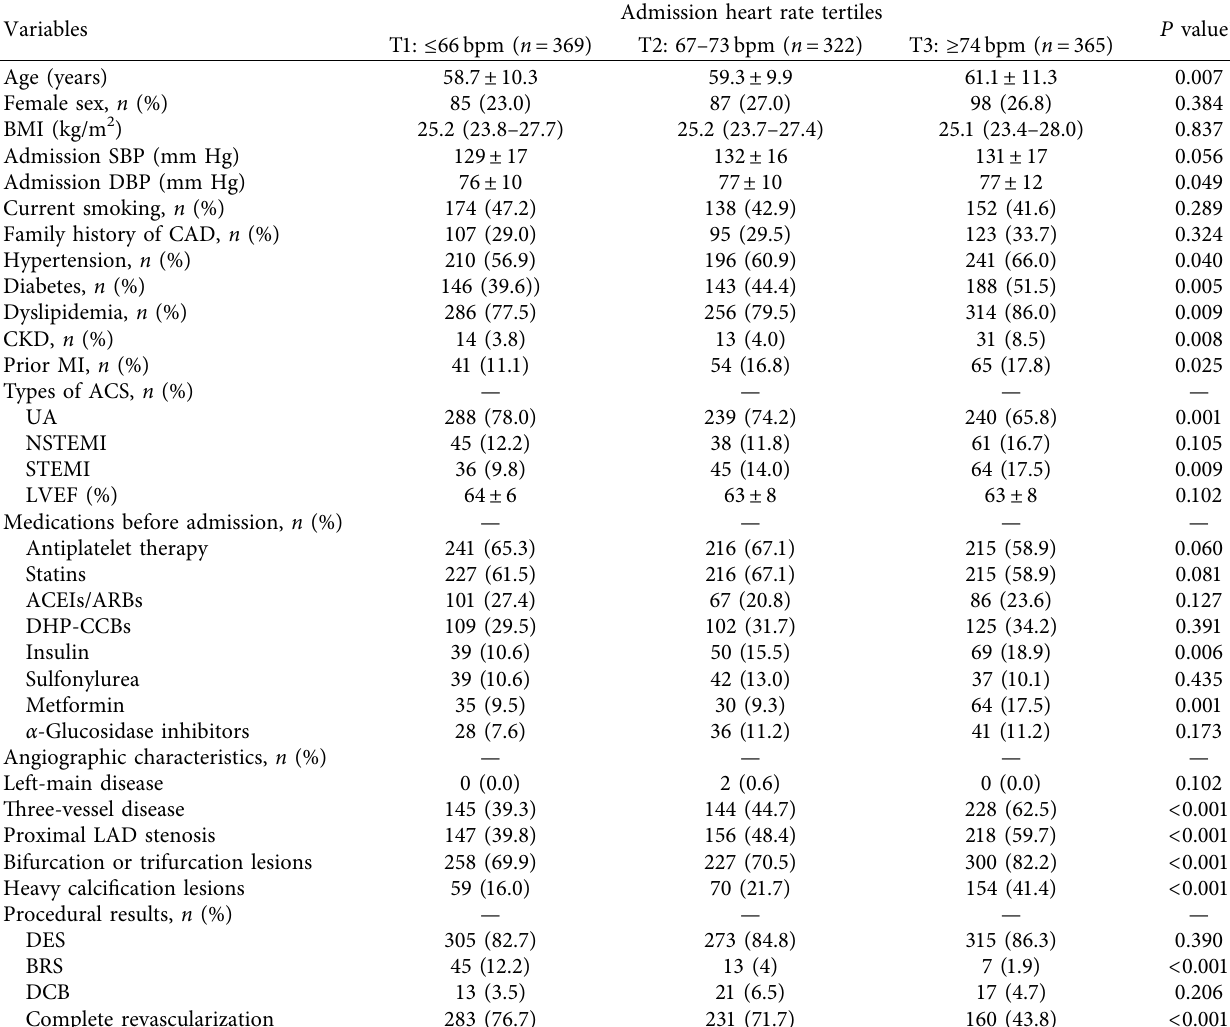
Table 1: Baseline characteristics of the study population according to admission heart rate.